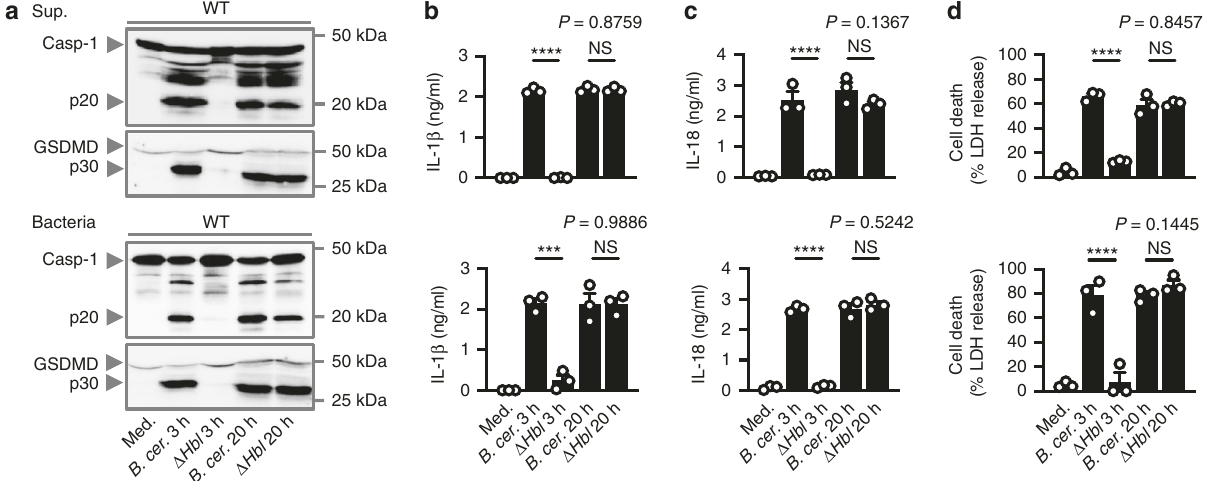
Fig. 1 A secreted factor of B. cereus activates the in fl ammasome independently of HBL. a Immunoblot analysis of pro-caspase-1 (Casp-1), the active caspase-1 p20 subunit, pro-pyroptotic effector protein gasdermin D (GSDMD), the active GSDMD p30 subunit of WT BMDMs left untreated [Medium alone (Med.)] or LPS-primed and assessed either 3 h or 20 h after stimulation with the supernatant of WT B. cereus ( B. cer .) or Δ Hbl B. cereus ( Δ Hbl ) (top; Supernatant (Sup.)) or infection with B. cer . or Δ Hbl (bottom; m.o.i. of 5). Release of IL-1 β b , IL-18 c , and cell death d of BMDMs as treated in a . NS, not signi fi cant, *** P < 0.001 and **** P < 0.0001 (student ’ s unpaired t test b – d ). Each symbol represents an independent experiment b – d . Data are representative of three independent experiments ( n = 3, a – d ; mean and s.e.m. in b – d ). Source data are provided as a Source Data fi